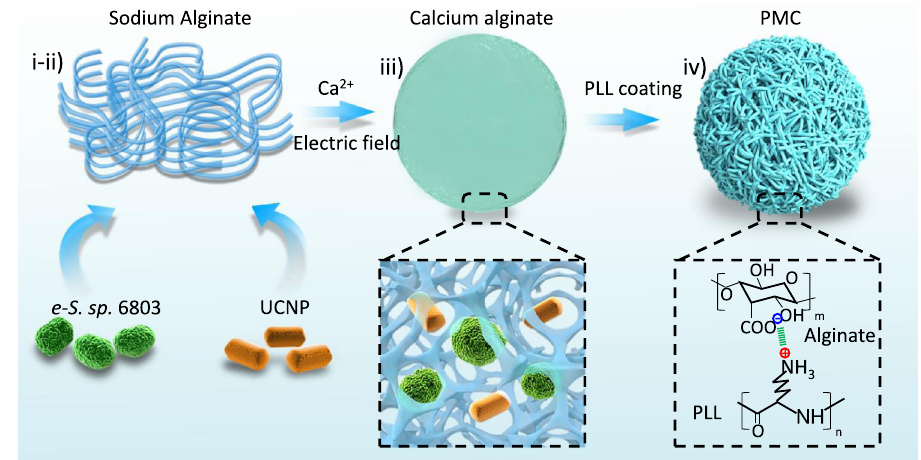
Fig. 1 | Schematic displaying the critical steps of PMC construction. (i) homo- genous mixing of algal microbes with UCNPs in alginate sodium; (ii) dispersing of alginate sodium solution into uniform droplets under an electrostatic fi